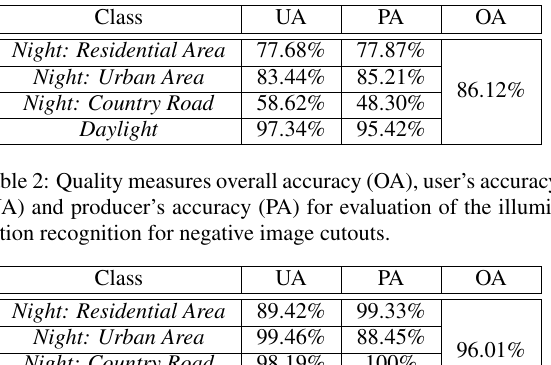
Table 1: Quality measures overall accuracy (OA), user’s accuracy (UA) and producer’s accuracy (PA) for evaluation of the illumi- nation recognition for positive image cutouts.